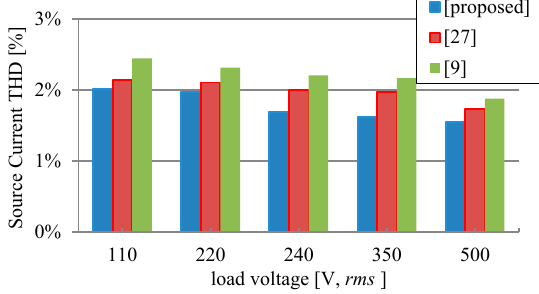
Figure 11. Source current THD in terms of load voltage.